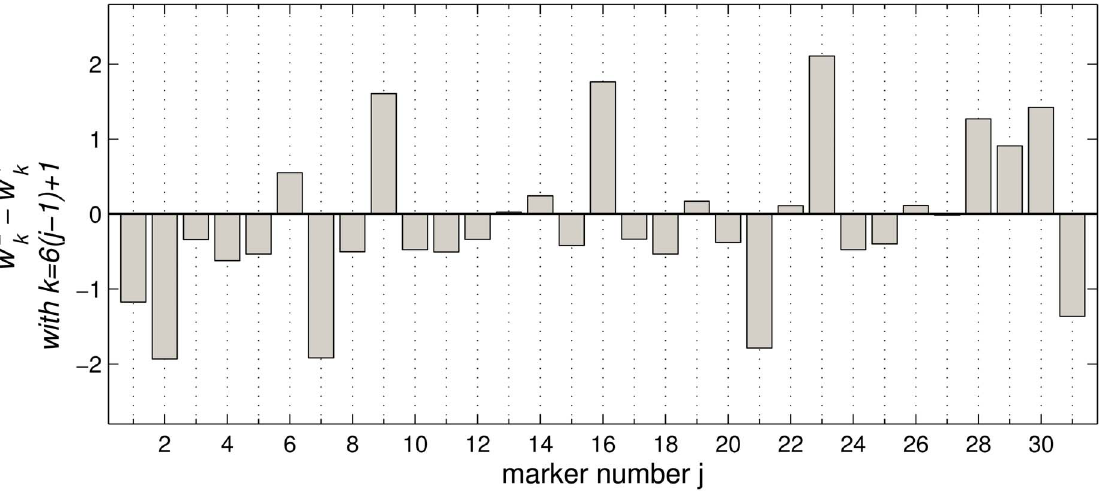
Figure 7. GMVLQ prototypes. Components of the difference vector ( w 2 { w 1 ) corresponding to the feature mean j , cf. Eq. (1), as represented by the AML prototype w 2 and healthy donor prototype w 1 . Positive bars indicate that mean j is typically greater in AML patients than in healthy donors. doi:10.1371/journal.pone.0059401.g007 PLOS ONE |